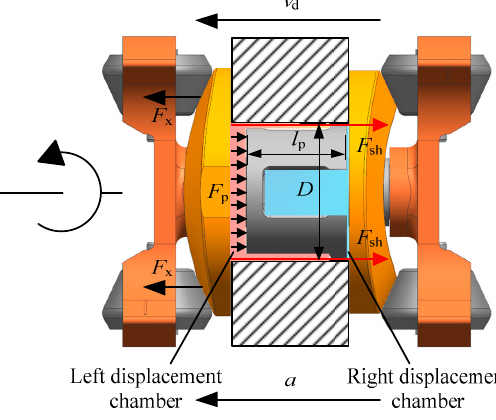
Figure 5. Force analysis of the driving set while rotating from 0 degrees to 45 degrees.